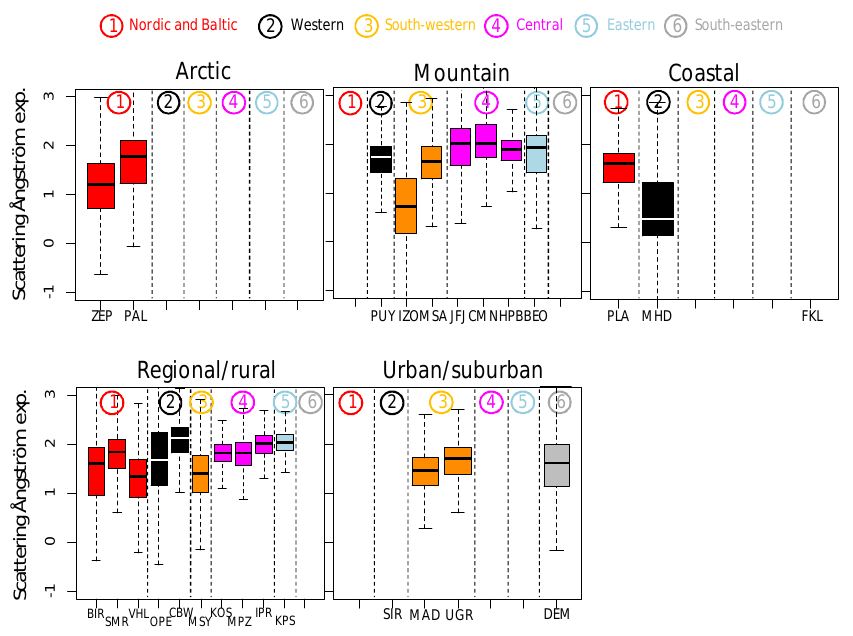
Figure 4. Scattering Ångström exponent divided by station setting. Different colours highlight different geographical locations. Medians (horizontal lines in the boxes), percentiles 25 and 75 (lower and upper limits of the boxes) and percentiles 5 and 95 (lower and upper limits of the vertical dashed lines) are reported. Hourly data were used for the